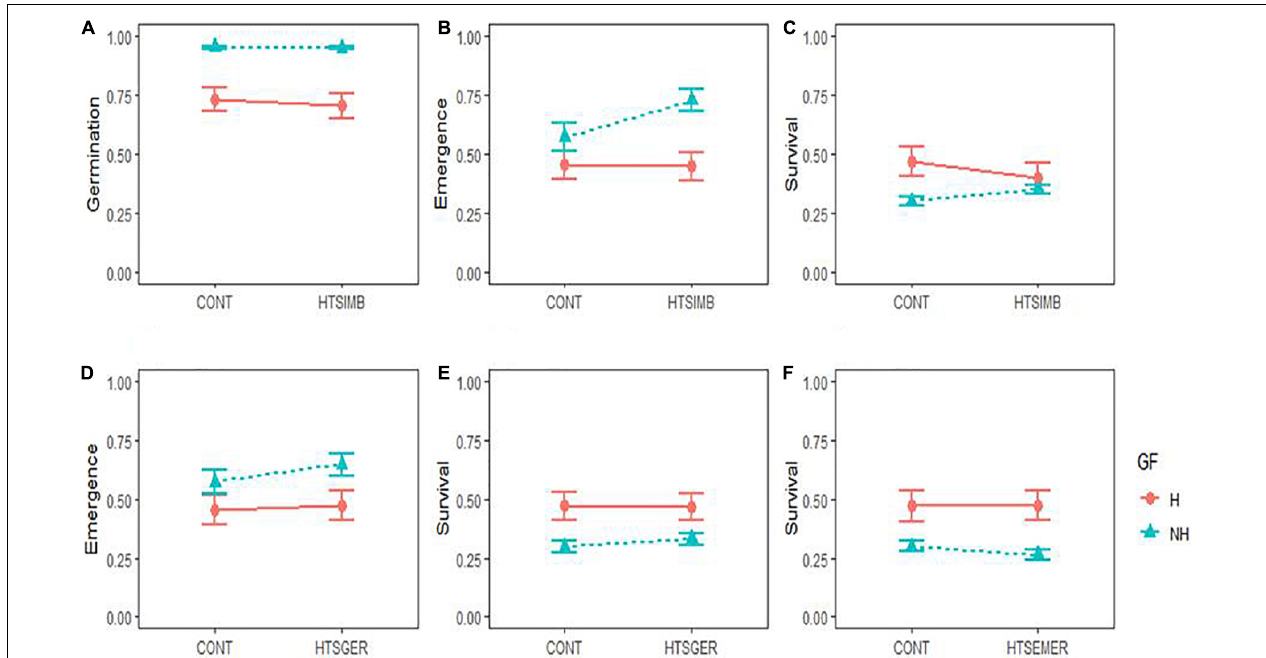
FIGURE 2 | Early regeneration responses in two growth forms (GF; H = hemiepiphytic and NH = non-hemiepiphytic) of Ficus species to high temperature stress (HTS) applied at different regeneration stages: seed imbibition (HTSIMB), seed germination (HTSGER), and seedling emergence (HTSEMER). The HTS was applied as 40 ◦ C for 8h from 10:00 am to 6:00 pm, and the respective control treatment (CONT) was not given an HTS treatment. The responses to HTSIMB were measured as the probability of seed germination (A) , probability of seedling emergence (B) , and probability of seedling survival (C) . The responses to HTSGER were measured as the probability of seedling emergence (D) and the probability of seedling survival (E) . The response to HTSEMER was measured as the probability of seedling survival (F)